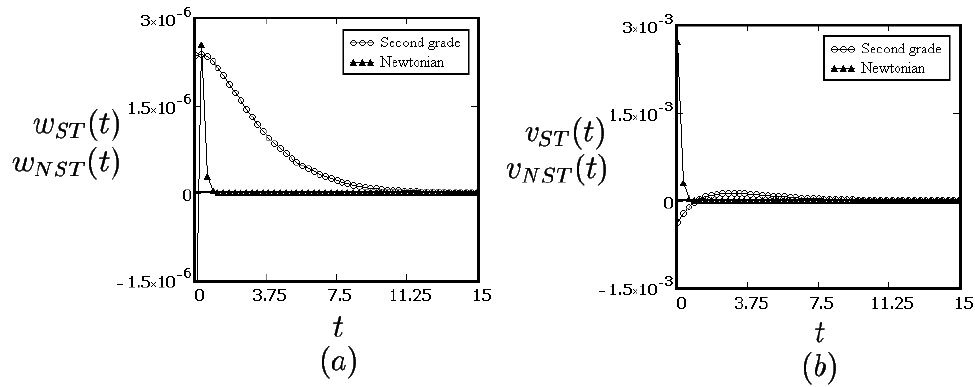
Fig. 10. Profiles of the transient velocity components w T ( r , t ) and v T ( r , t ) given by Eqs. (42), (43), (68) and (69) for R 1 = 0.3, R 2 = 0.5, f = g = −2, ω 1 = ω 2 = 1, ν = 0.1188, µ = 10.384, α = 0.2 and r = 0.4